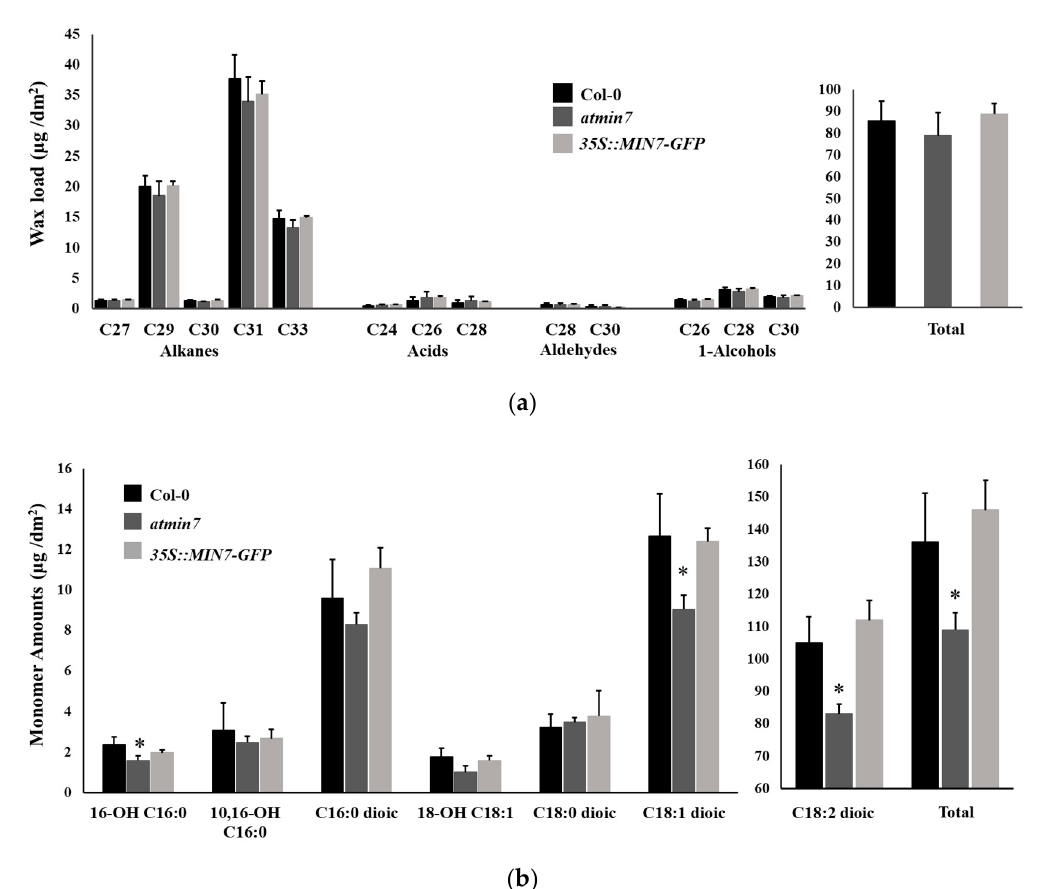
Figure 4. The content of cutin monomers, but not cuticular wax, is abnormal in the leaves of atmin7 mutant plants. ( a ). Wax load with different chain lengths and total content in the leaves of WT, atmin7 , and 35S::MIN7-GFP plants are shown as mean +/- SD. Unpaired two-tailed Student’s t -tests with WT did not show significant differences to atmin7 or 35S::MIN7-GFP plants (* p < 0.05). ( b ). The abundance of cutin monomers and total content in the leaves of WT, atmin7 , and 35S::MIN7-GFP plants are shown as mean +/- SD. The C16 and C18 labels on the x -axis represent the 16- and 18-carbon acid chains, respectively, whereas the number preceding “OH” indicates the chain insertion point(s). Dioic represents dioic acid. Unpaired two-tailed Student’s t -tests with WT show significant differences versus atmin7 and complementation line plants (* p < 0.05).